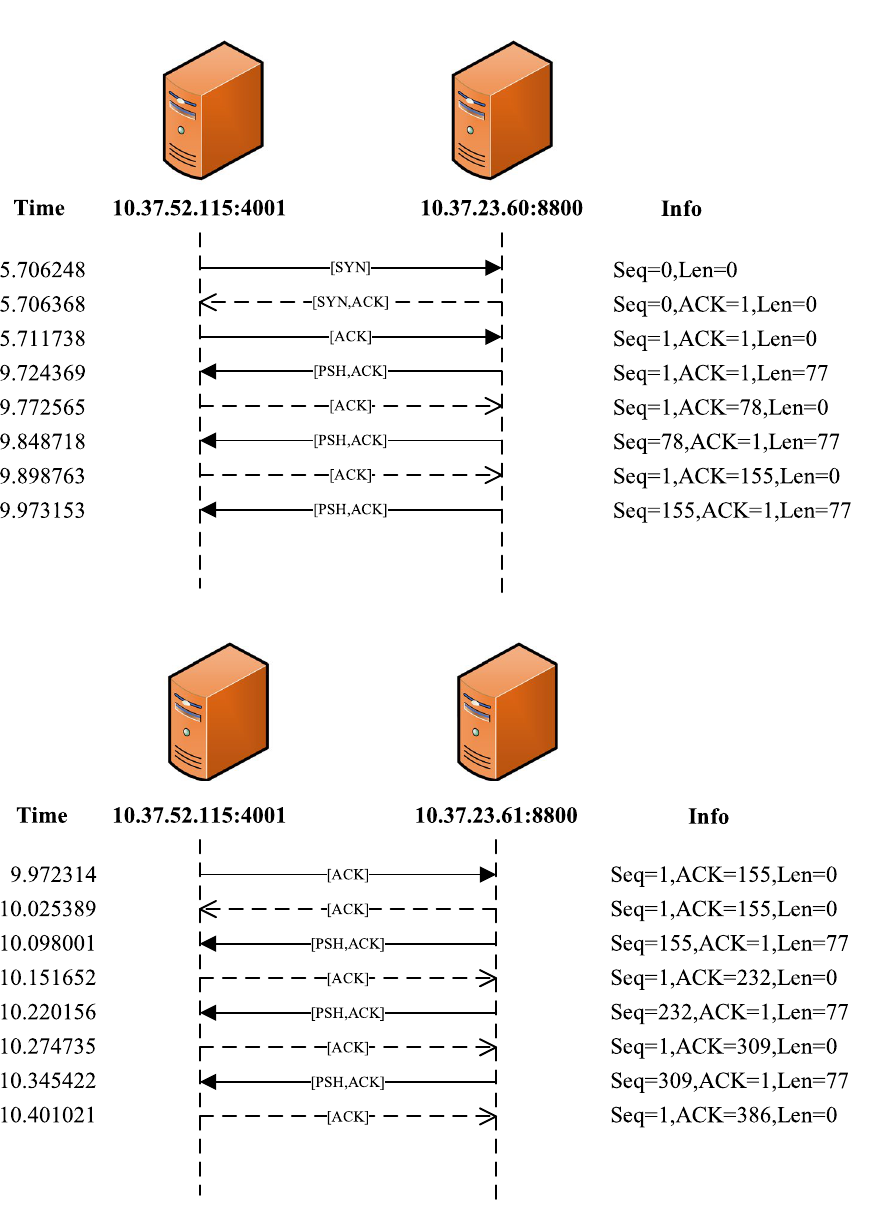
Fig. 8 Traffic exchange diagram before and after TCP_REPAIR